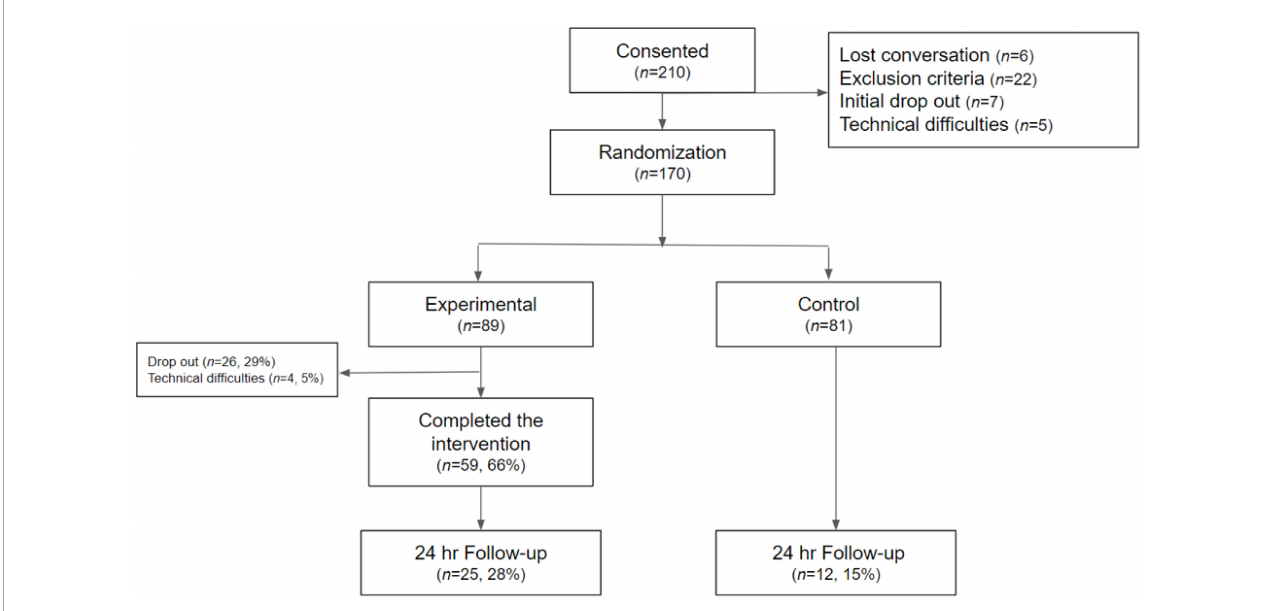
FIGURE4 CONSORT